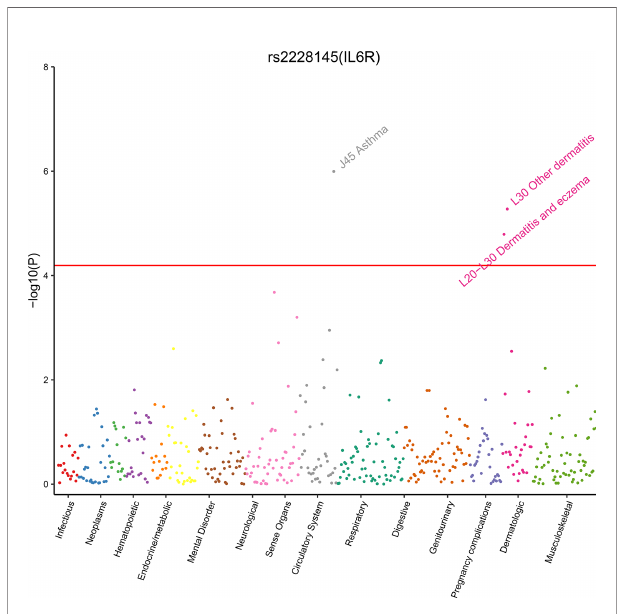
FIGURE 2 | Plotofphenome-wideanalysisforrs2228145usingdatafromUB Biobank.Weestimatedrs2228145associatedwith778phenotypesinUKBiobank cohort.Phenotypesaregroupedalongthe x -axisbycategorizationwithinthePheWAS codehierarchy.Weconsidereda p -value<6.43×10 − 5 (theredline)assigni fi cant.